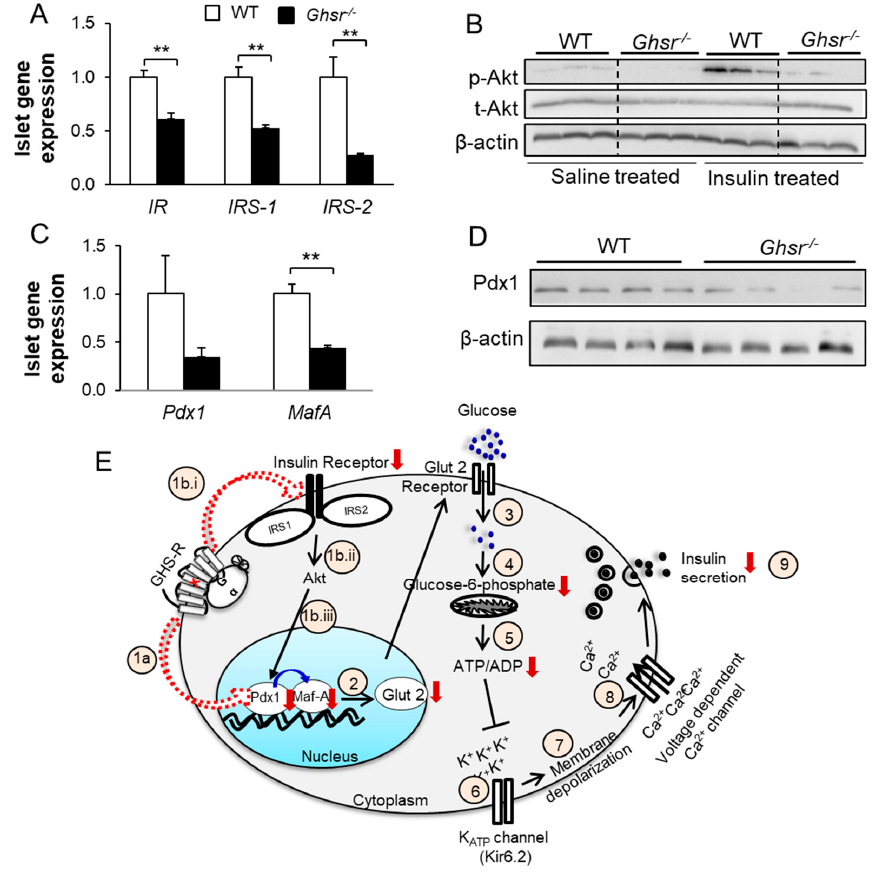
Figure 4. Genes of IR-IRS1/IRS2 pathway and transcription factor Pdx1 are downregulated in Ghsr − / − mice. ( A ) Gene expression of IR, IRS1, and IRS2 were measured in islets of 6.5-month-old mice, n = 5. ( B ) Protein expression of p-AKT and t-AKT was measured in the pancreas from 12–14-month-old WT and Ghsr − / − mice injected with saline or insulin. ( C ) Gene expression of transcription factors, Pdx1, and MafA were measured in islets of 6.5-month-old mice, n = 5. ( D ) Protein expression of Pdx1 was measured in the pancreas of 5-month-old WT and Ghsr − / − mice, n = 4. ( E ) Schematic diagram illustrating that GHS-R regulates GSIS via the AKt-Pdx1 pathway. The numbers in the diagrams are denoted as below: (1) GHS-R ablation in β -cells downregulates Pdx1 and MafA either directly or indirectly reducing the expression of insulin signaling of IR, IRS1, IRS2, and Akt; (2) The downregulation of Pdx1 and MafA impairs Glut2 expression; (3) Reduced Glut2 expression leads to decreased glucose uptake; (4) Reduced generation of Glucose-6-phosphate leads to lower ATP/ADP ratio; (5) Reduced ATP/ADP ratio causes partial closing of ATP sensitive K ATP channels (6), which leads to insufficient membrane depolarization (7); This ultimately results in a reduced influx of Ca 2+ ions (8) that suppresses insulin secretion (9). * p < 0.05, WT vs. Ghsr − / − ; ** p < 0.001, WT vs. Ghsr − / − .